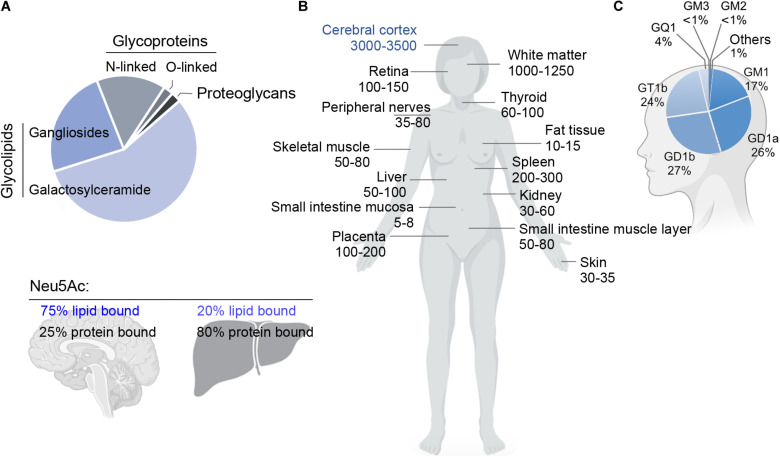
(A) Relative abundance of glycoproteins, glycolipids and proteoglycans in the adult rat brain (top), and fraction of sialic acid (Neu5Ac) bound to lipids (gangliosides) or proteins in brain and liver (bottom). Glycosphingolipids represent ∼80% of the total mass of glycans and carry ∼75% of the sialic acid residues in the adult brain. Data adapted from Schnaar (2004) and Schnaar et al. (2014). (B) Concentration of gangliosides in human organs (nmol NeuAc/g of fresh tissue weight) (left). Data adapted from Svennerholm (1980). (C) Relative abundance of individual gangliosides in the human brain (right). The human brain expresses a higher proportion of gangliosides of higher complexity compared to other tissues. Data adapted from Tettamanti et al. (1973).